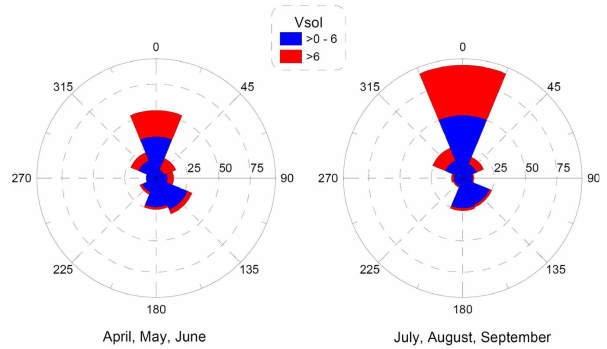
Fig. 6. Number of cases with V sol < 6ngm − 3 (blu regions) and V sol > 6ngm − 3 (red regions) for different originating directions of the corresponding airmass trajectories for April-May-June (left), and July-August-September